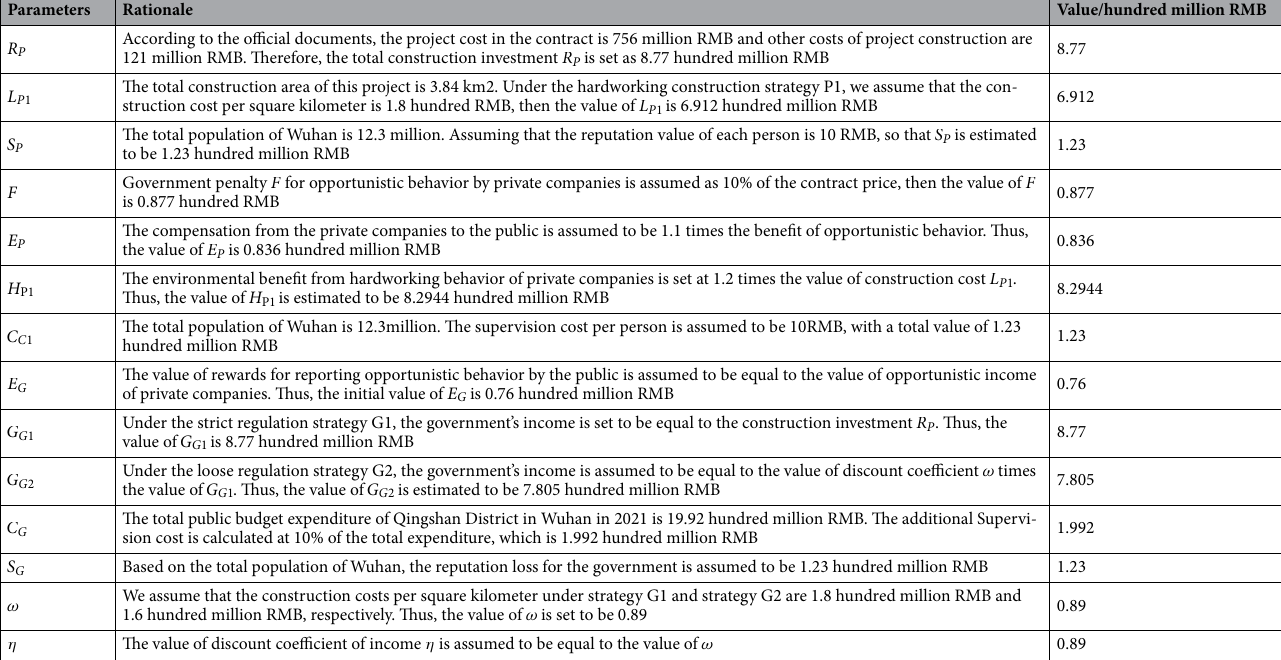
Table 4. Initial parameter values of tripartite evolutionary game model.